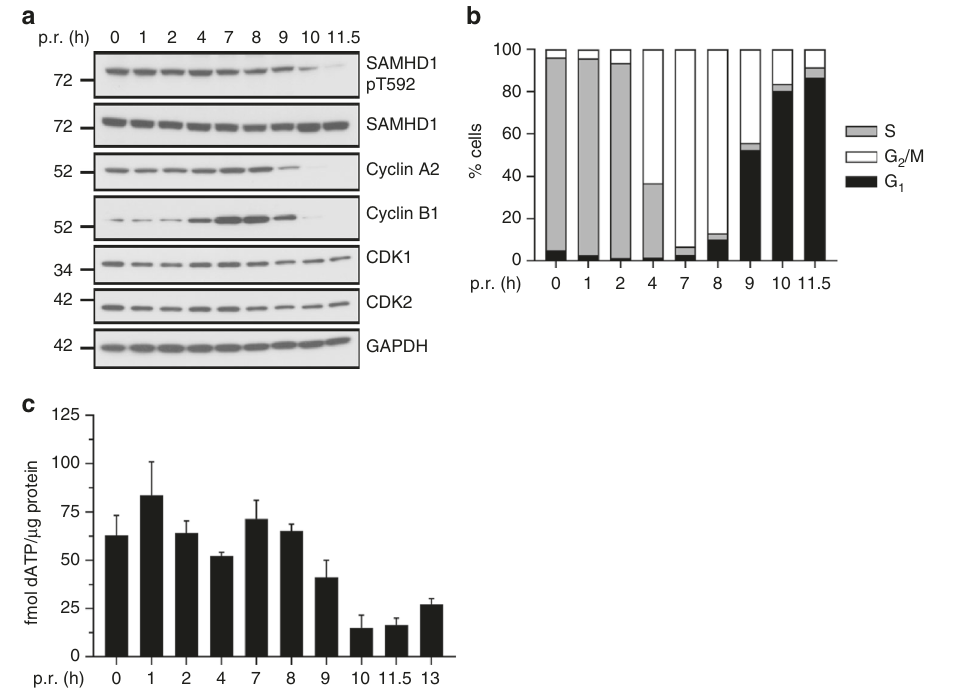
Fig. 1 SAMHD1 (de)phosphorylation at T592 is regulated in a cell cycle dependent manner. a , b HeLa cells were arrested at the G 1 /S border using a double- thymidine block. After the 2nd release, synchronized cells were harvested at different time points post-release (p.r.). Respective samples were split for immunoblotting ( a ) and propidium iodide (PI) staining ( b ) to determine cell cycle-phases by fl ow cytometry. For immunoblotting, whole-cell lysates were analyzed using antibodies speci fi c to the indicated proteins. Data shown are representative of two independent experiments. c HeLa cells were arrested at the G 1 /S border and harvested at different time points as described in Fig. 1a. Respective samples were split for dATP measurement, immunoblotting (Supplementary Fig. 1a, c) and PI staining (Supplementary Fig. 1b). dATP was quanti fi ed by single nucleotide incorporation assay and normalized by protein content of the corresponding lysate. Data shown represent the mean ± SD of two independent